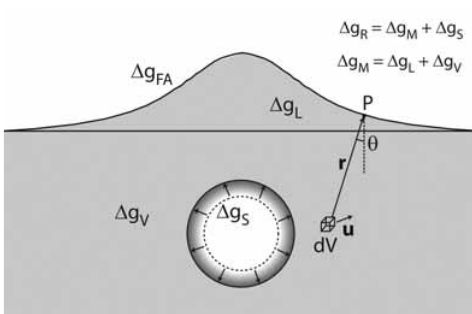
Fig. 3. Schematic representation of the gravity con- tributions: ∆ g FA is the free-air change proportional to the uplift; ∆ g L is the change caused by the lifted por- tion of the ground (Bouguer anomaly) and of inter- faces between density layers; ∆ g V is the gravity field due to the medium compressibility; ∆ g S is the contri- bution of the material filling the expanding part of the source. In the right hand side of the figure is in- dicated the geometry of the gravity integration of el- ementary volume dV , its displacement u , the obser- vation point P , the vector R between dV and P , and the angle θ between